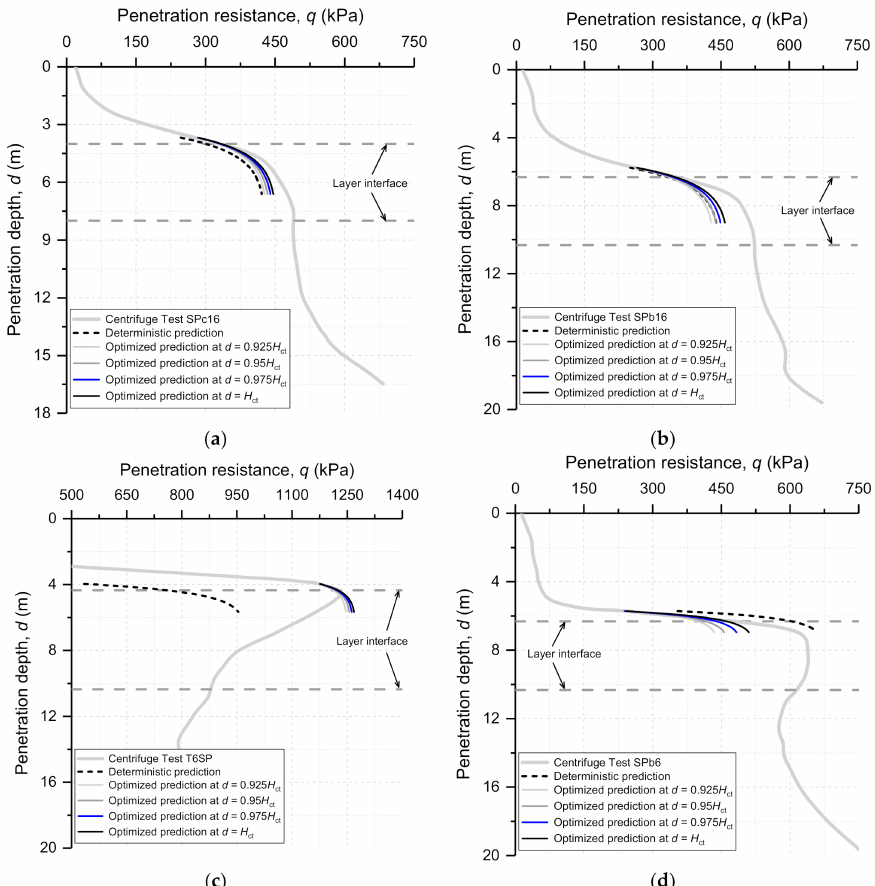
Figure 10. Variation of predicted penetration resistance profile with the optimization at each observa- tion location. ( a ) Test SPc16; ( b ) Test SPb16; ( c ) Test T6SP; ( d ) Test